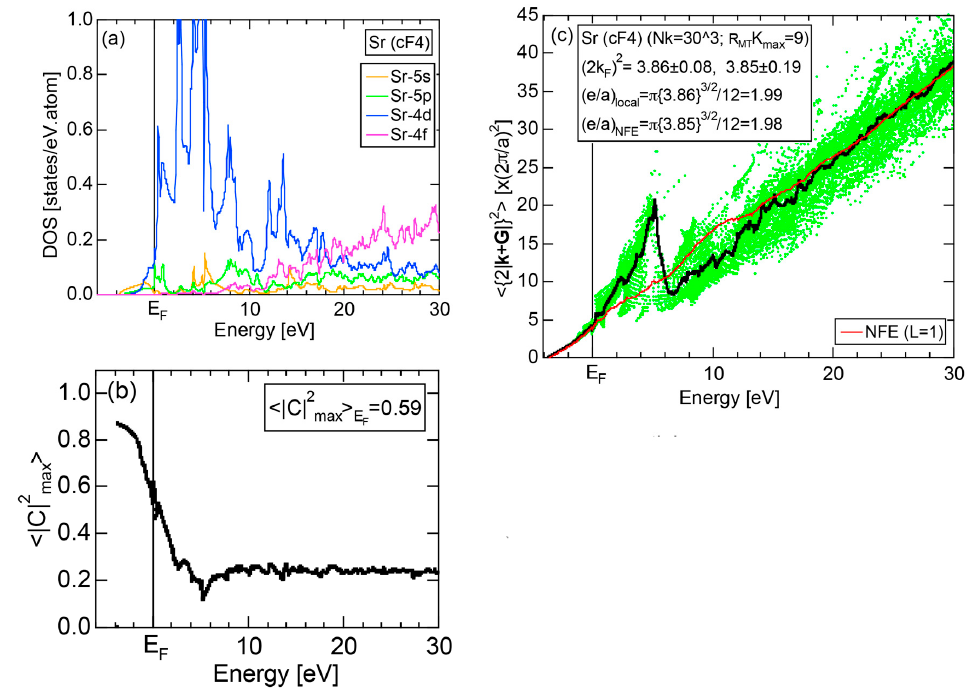
(cid:69) (cid:68) | C | 2 max2 and ( c ) Hume-Rothery plot for Sr (cF4) max and ( c ) Hume-Rothery plot for Sr (cF4). See captions of E E